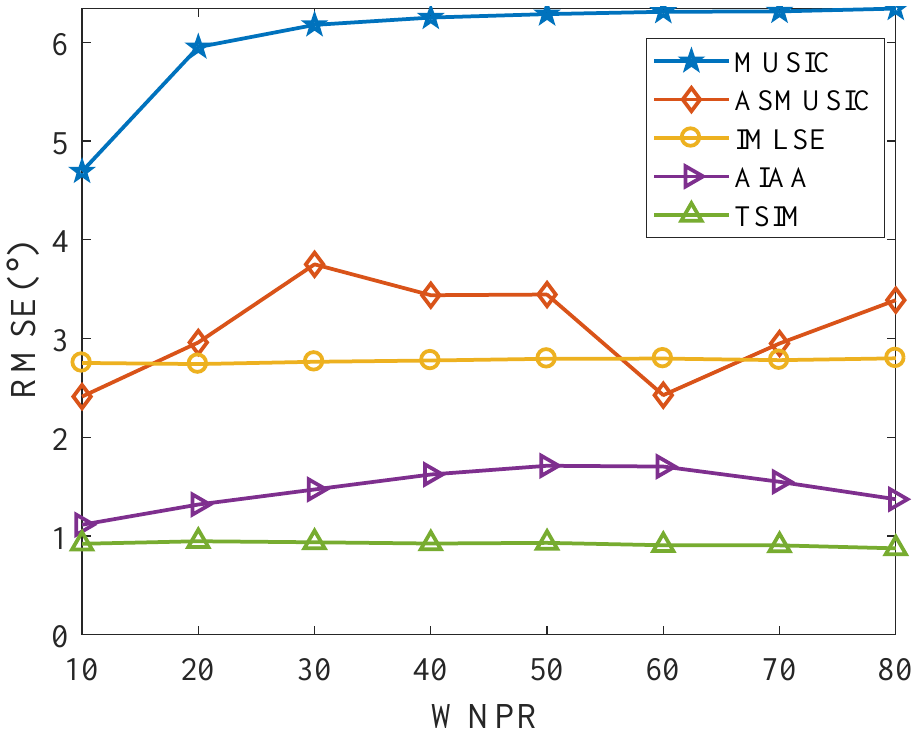
Figure 5. RMSE versus WNPR with SNR = 5 dB, L = 300, µ = 15, and σ = 4 under non-uniform